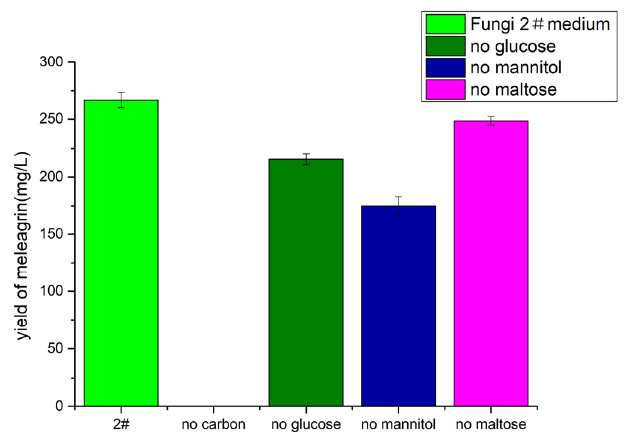
Figure 11. The yield of meleagrin under different carbon sources. ＃ represents the number of the culture